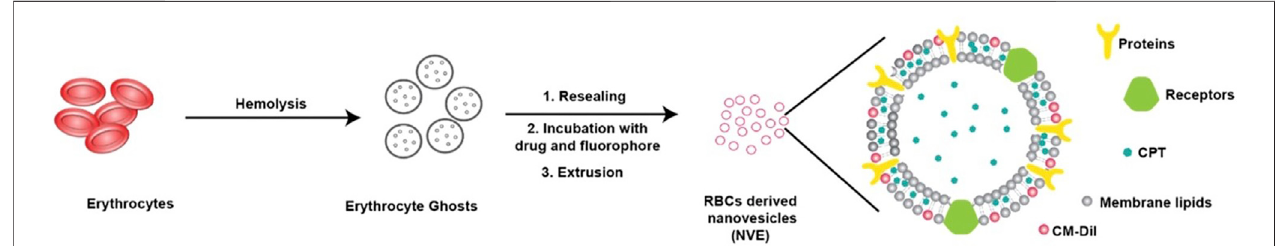
FIGURE 6 | Schematic representation showing usages of RBC membrane for loading a lipophilic drug, camptothecin, for theranostic application. Adapted from Malhotra et al. (2019). Copyright @ 2019 (American Chemical Society).